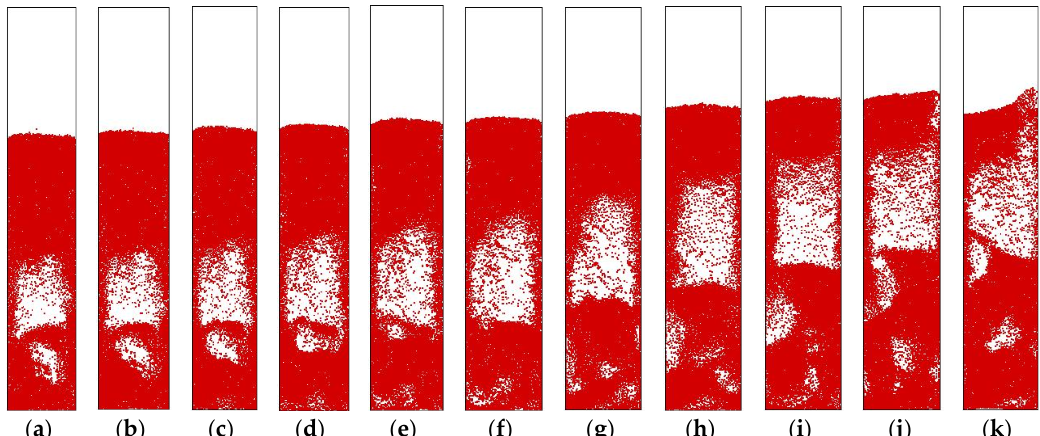
Figure 12. Snapshots of particle distribution obtained by the PCPM for a two dimensional fluidized bed at the very early stage: the phenomenon of bubble merging along the vertical direction and rectangular bubble formation. ( a ) 1.00 s. ( b ) 1.04 s. ( c ) 1.08 s. ( d ) 1.12 s. ( e ) 1.16 s. ( f ) 1.20 s. ( g ) 1.32 s. ( h ) 1.44 s. ( i ) 1.56 s. ( j ) 1.68 s. ( k ) 1.80 s.